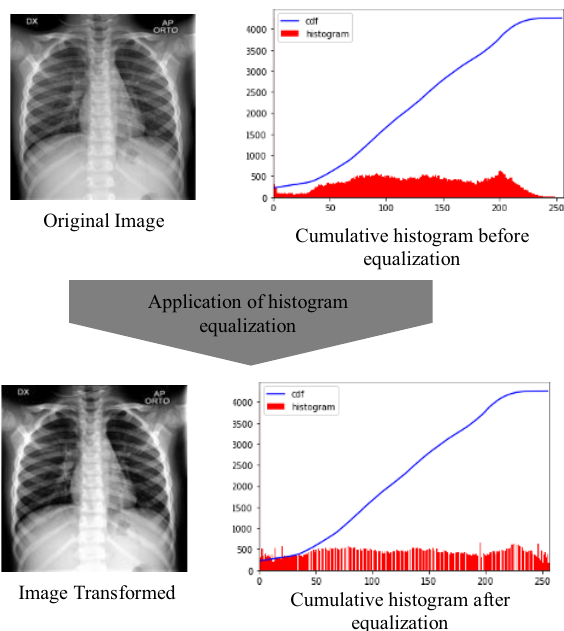
Fig. 1. Some images of the data set used, (a) COVID-19 positive cases, (b) Normal